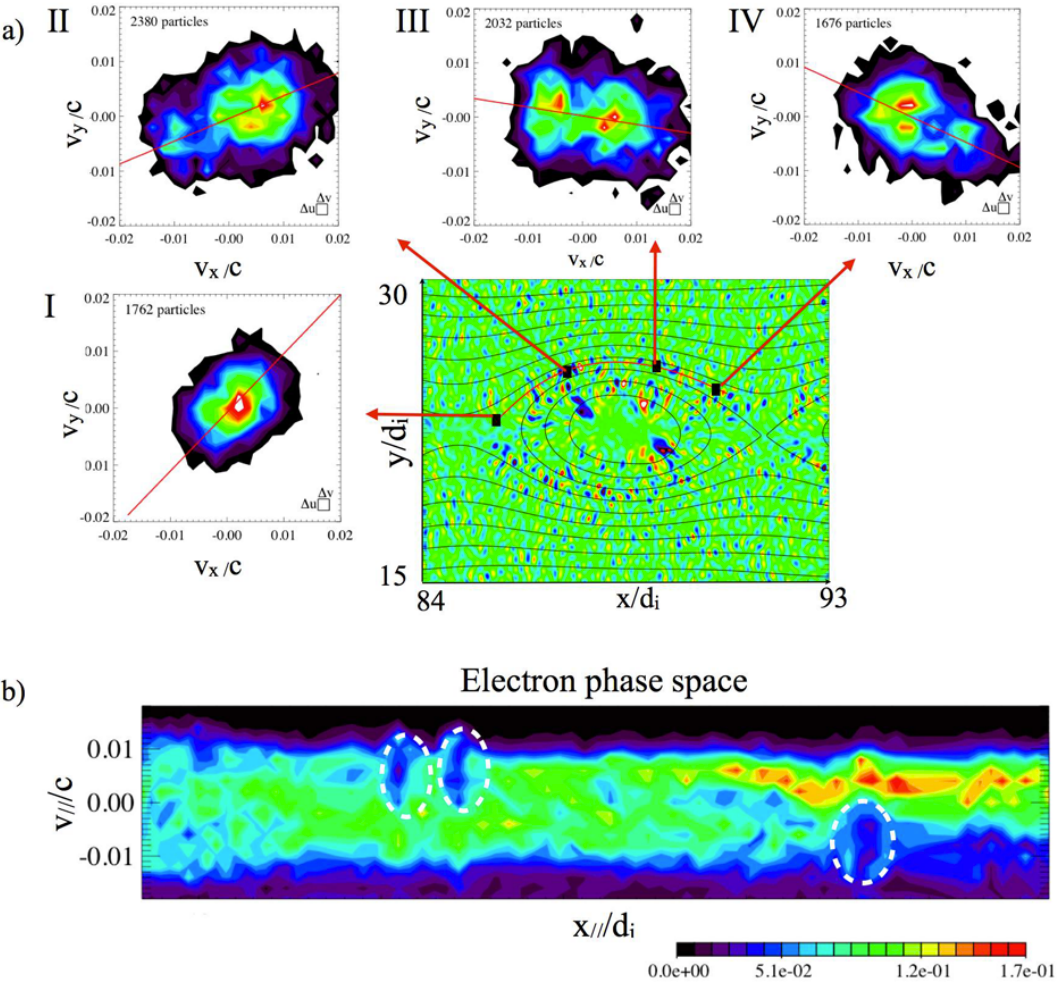
Fig. 9. Electron distribution functions, x // vs. v // (curvilinear coordinate along the red line in (a) vs. the parallel velocity), at four different locations (black boxes) at time (cid:127) ci t = 18 . 62 in (a) . The red line in the distribution functions shows the direction of the magnetic field. Electron phase space along the red line of (b) with phase space holes, encircled in white dashed lines. The electron distribution functions show the presence of counter-streaming electron beams, while the phase space plots reveal the presence of electron phase pace holes along the